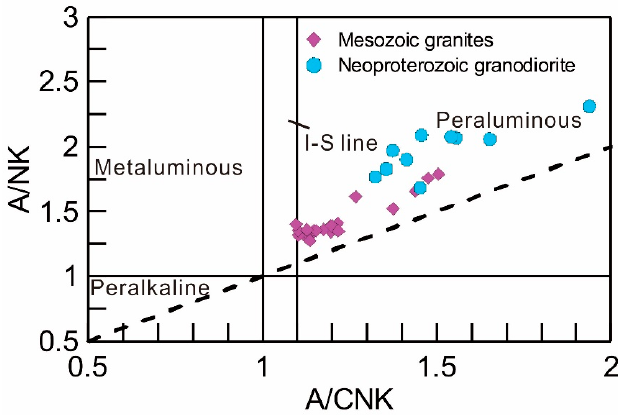
Figure 11. A/CNK vs. A/NK diagram. Data of the ore-related Mesozoic Shimensi granites are from Wei et al. [6].